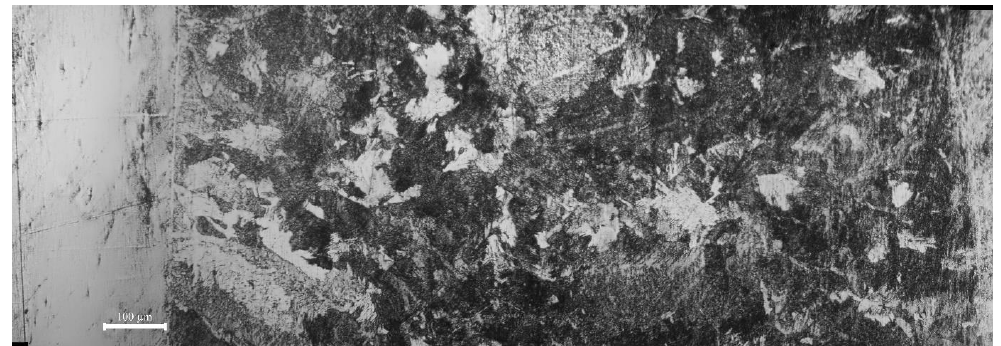
Fig. 1. Panorama of the point welded connection of the source materials (Armco iron and steel of common quality carbon steel)